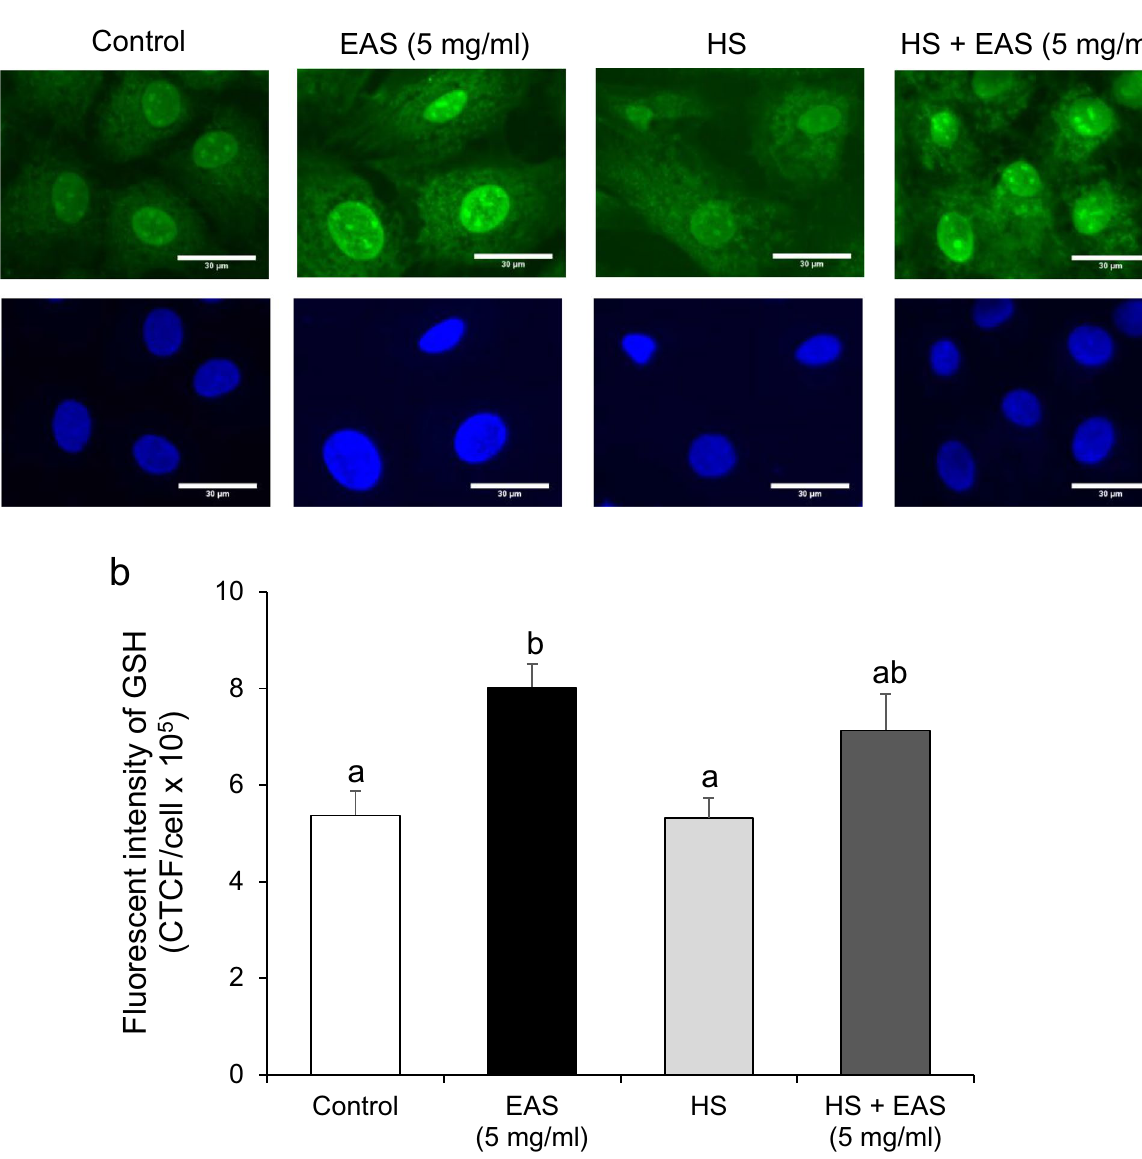
Figure 6. Effect of EAS on GSH synthesis in the bovine CG cells under non- and HS conditions. Cells were treated for 6 h with or without EAS (5 mg/ml) under normal conditions at 38.5 °C (control, EAS group) and HS conditions at 41 °C (HS, HS + EAS group). ( a ) Fluorescence of GSH (upper) and nuclei stained with Hoechst (lower). Scale bar shows 30 μm. ( b ) Fluorescence intensity of GSH (CTCF). Data are shown as the mean ± SEM, n = 5, a vs. b ( P <